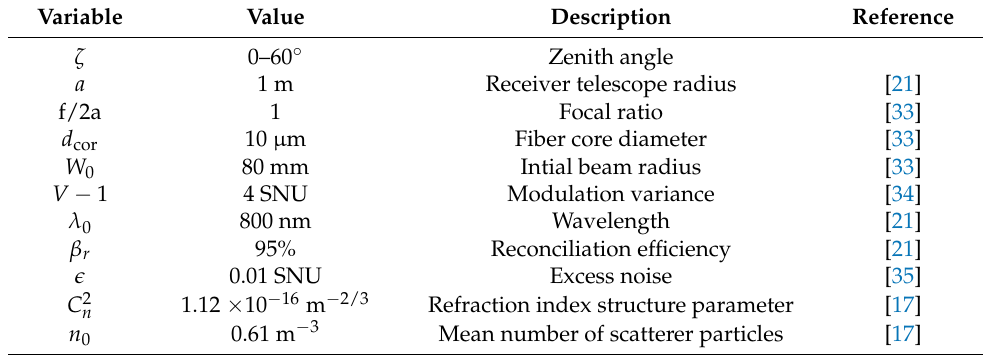
Table 1. The simulation parameters.